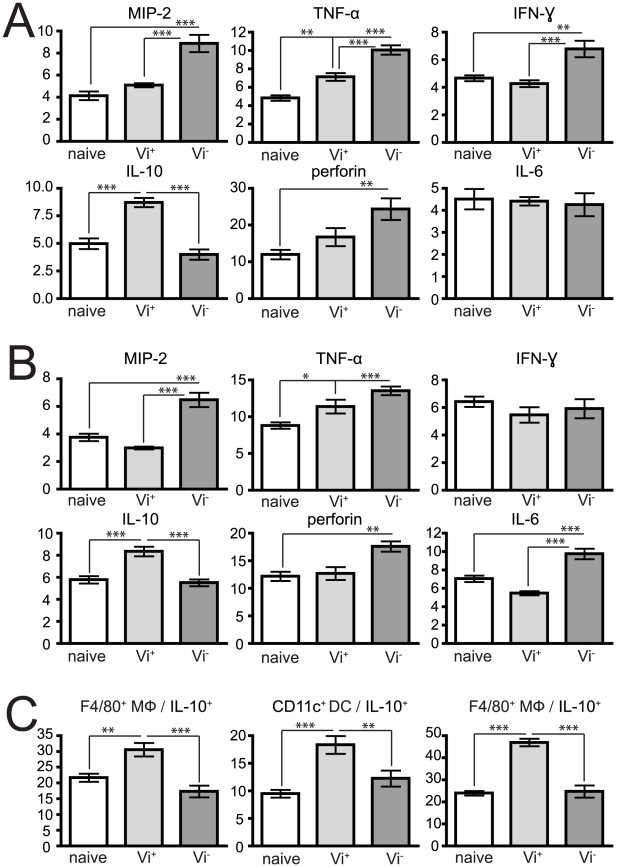
Vi expression also impacts on the cytokine profile of cells after S. Typhimurium infection.Isolated splenocytes after i.v. infection (A) or MLN after oral infection (B) from naïve, or 24 h infected C5507 (Vi+) and SGB1 (Vi−) mice were stimulated for 6 h with BD Leukocyte Activation Cocktail with BD GolgiPlug (BD Biosciences) in vitro, permeabilised and stained with anti-cytokine flurochrome-labelled mAb. (C) Cells were stained with mAb to specific surface markers F4/80+, CD11c+ and DX5+/CD3− the identity of innate populations, permeabilised and stained with anti-IL-10. Data represent percent of cytokine positive cells out of total spleen populations ± SEM. Significant differences in values of * p<0.05; **, p<0.01; ***, p<0.001, as determined by one-way ANOVA followed by Bonferroni's multiple comparison test.